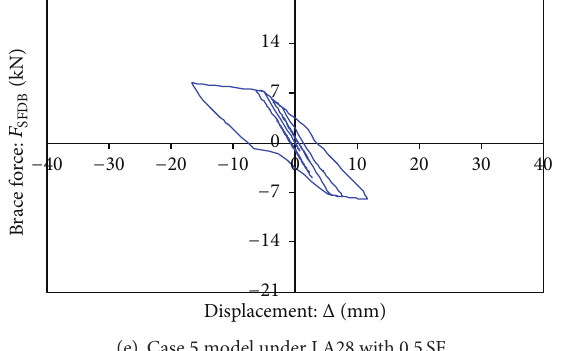
Figure 10: Force and displacement curves for individual SFDB models under the LA28 ground motion with 0.5